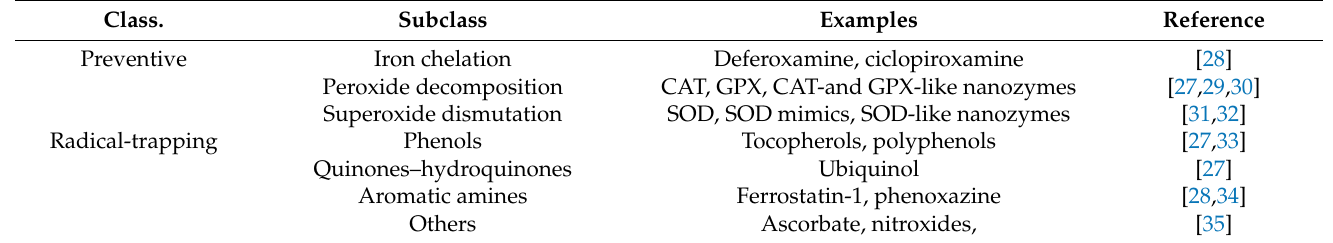
Table 1. Classification of antioxidant systems and main representative molecules, enzymes, or nano-